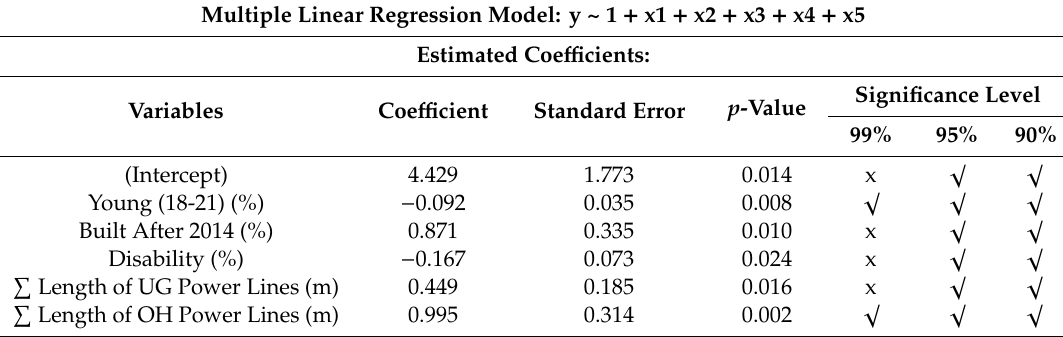
Table 5. Model results for Hurricane Michael-induced roadway